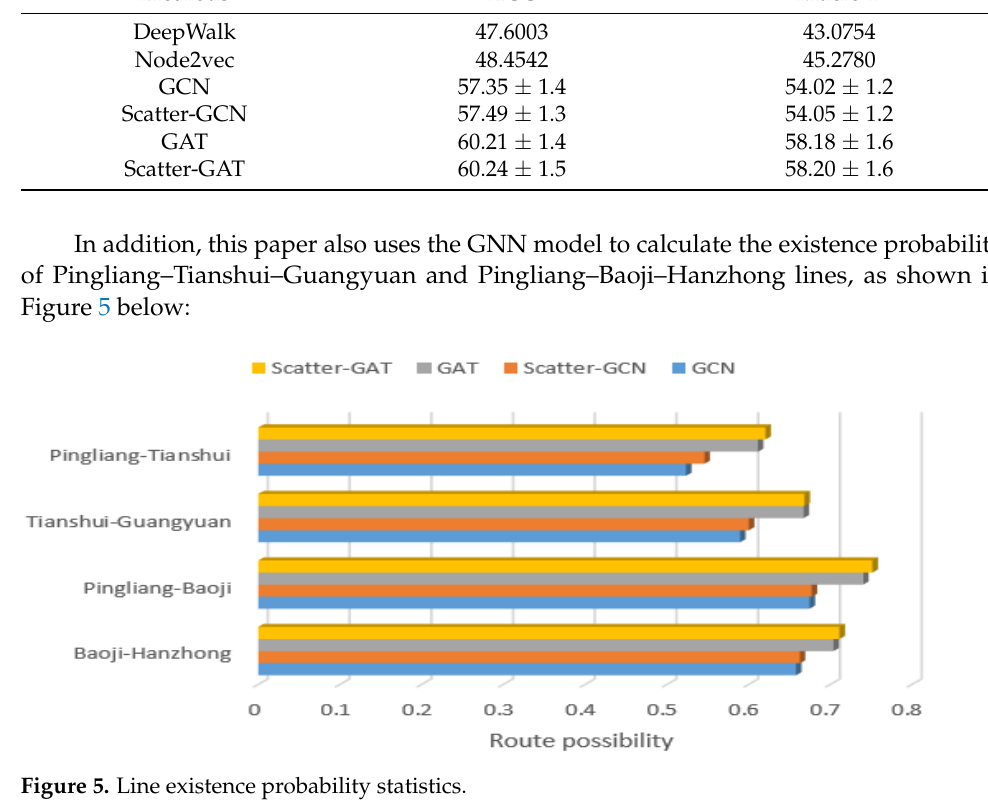
Figure 5. Line existence probability statistics.